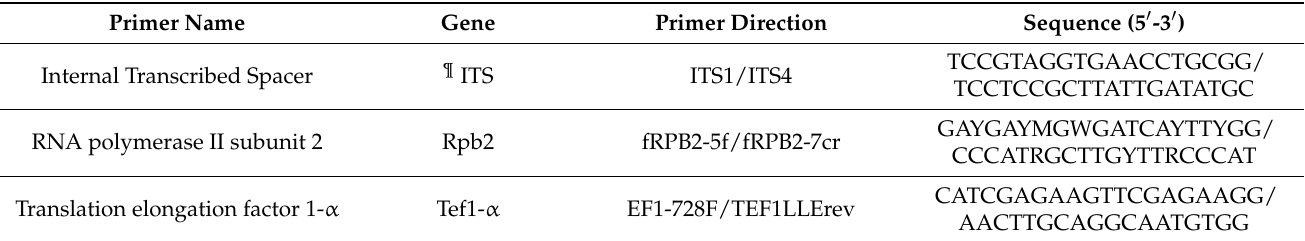
Table 1. The primer names and sequences used in PCR amplification